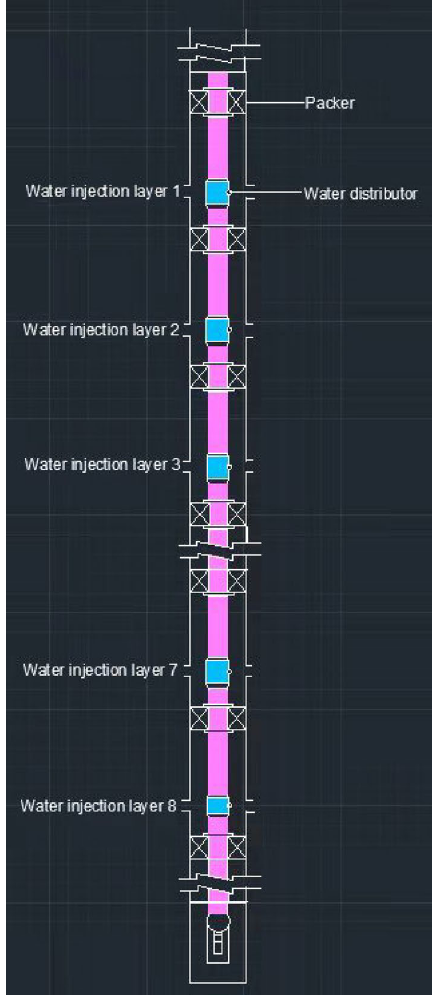
Fig. 1 Schematic diagram of the structure of layered injection pipe